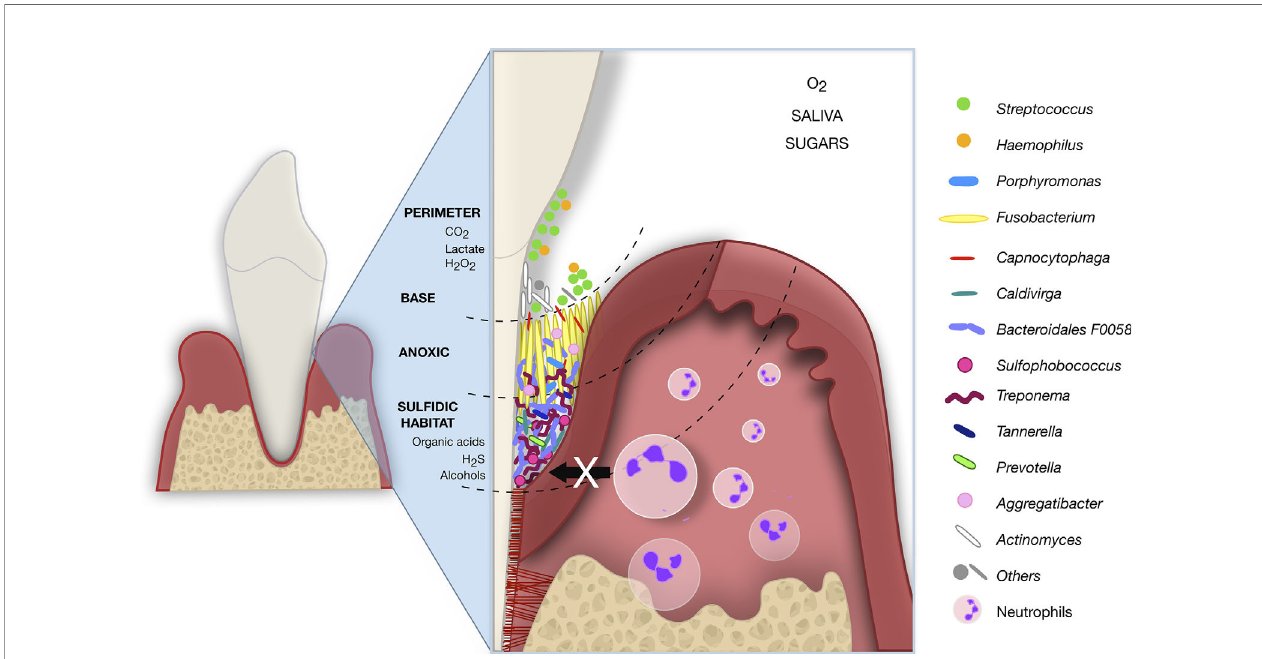
FIGURE 6 | Hypothetical subgingival microbiome biogeography of PLST. The just erupted teeth serve as attachment support for ubiquitous commensals that form an initial pellicle ( Streptococcus and Actinomyces ). The neutrophils in fi ltration and fi rst line of defense are impaired due to an ineffective cathepsin C. The attached aerobic microbes then serve as a substrate for further colonizers. Fusobacterium , also a ubiquitous bacterium, plays a crucial role as a bridge between the fi rst and late colonizers. Fusobacterium produces hydrogen sulfate (H 2 S), overgrows, and creates a sul fi dic habitat ideal for anaerobic such as Treponema , Porphyromonas , Prevotella , Tannerella , Sulfophobococcus , Caldivirga , and Bacteroidales F0058. The schematic image represents a hypothesis for PLST and was inspired by Mark Welch et al.